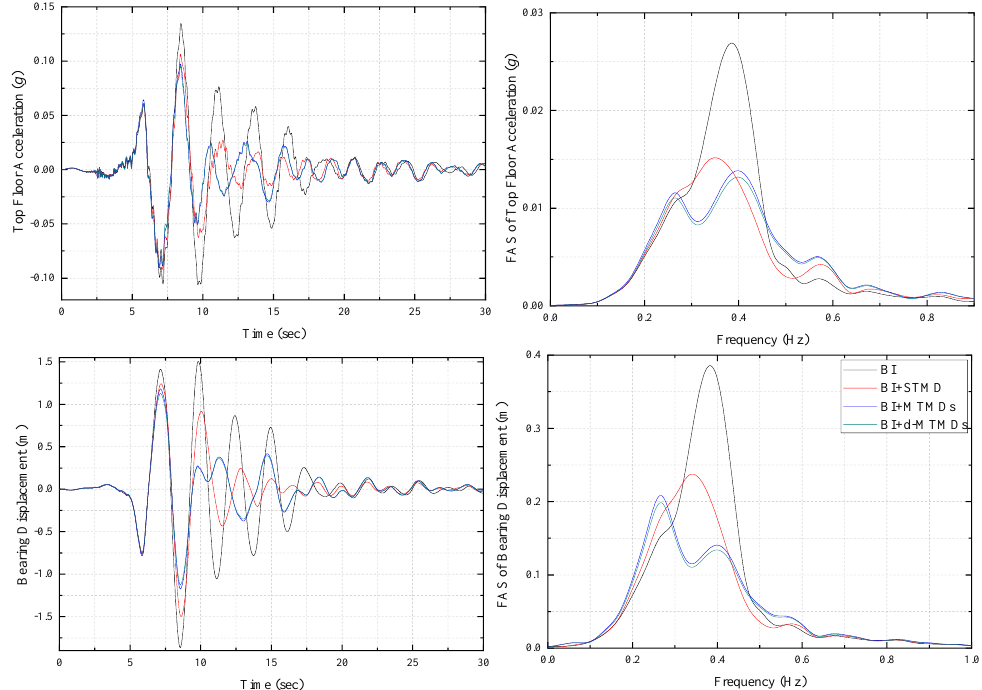
Figure 4. Time history and Fourier Amplitude Spectra (FAS) of top floor acceleration and bearing displacement of 5 story BI and BI equipped by TMD schemes under LA04 earthquake ground motions.